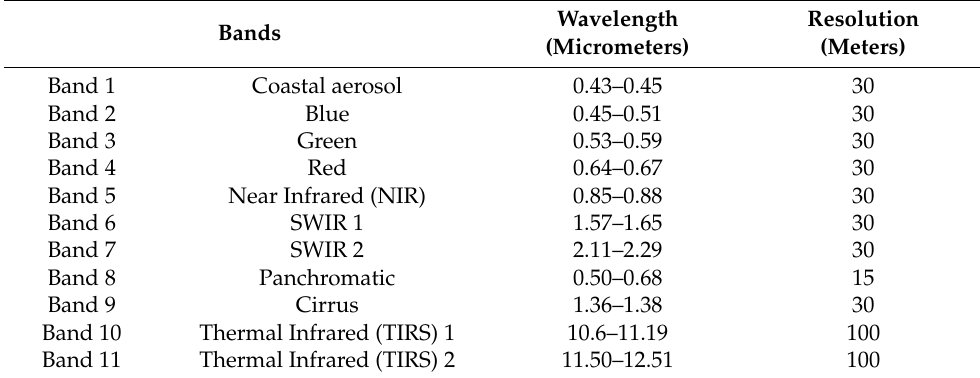
Table 2. Technical characteristics of Landsat 8 OLI